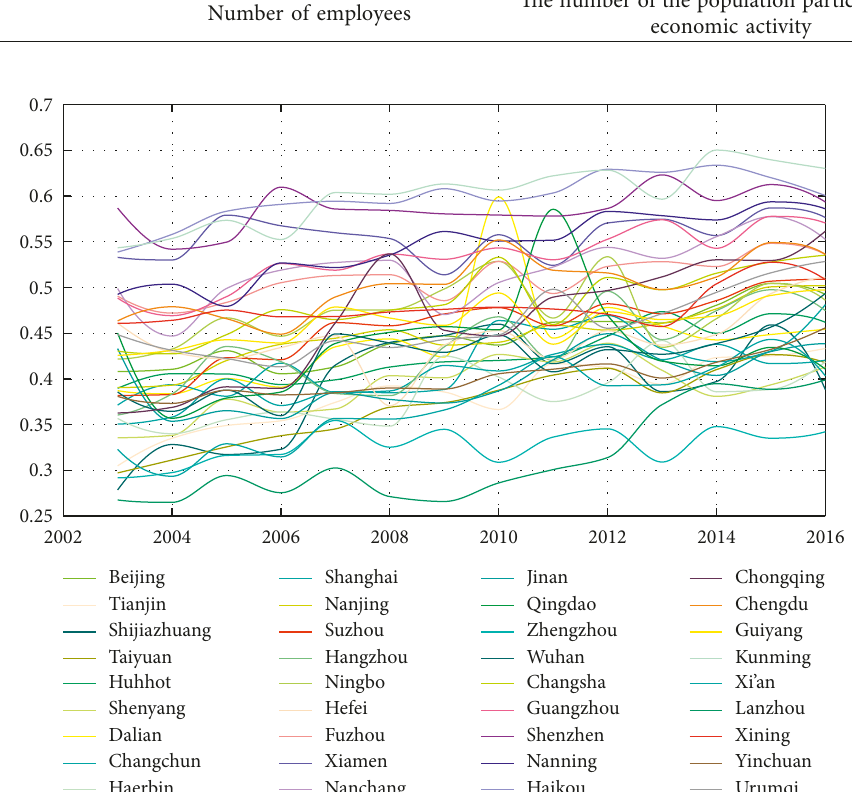
Figure 1: Trends of comprehensive levels of 36 main cities’ UPE